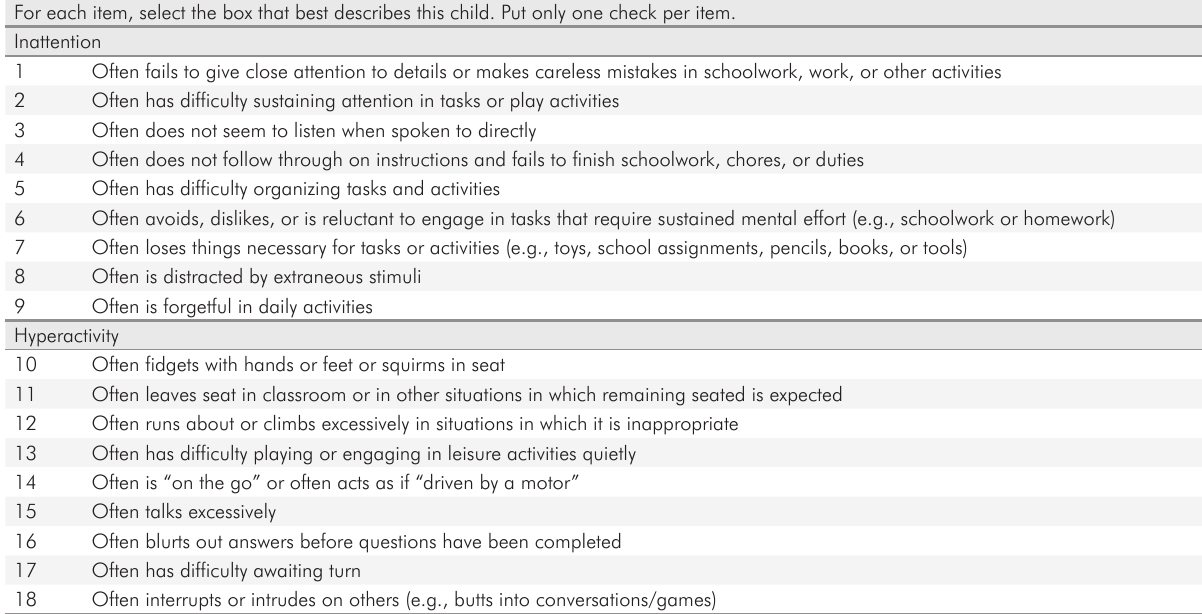
Table 1. Description of SNAP IV scale